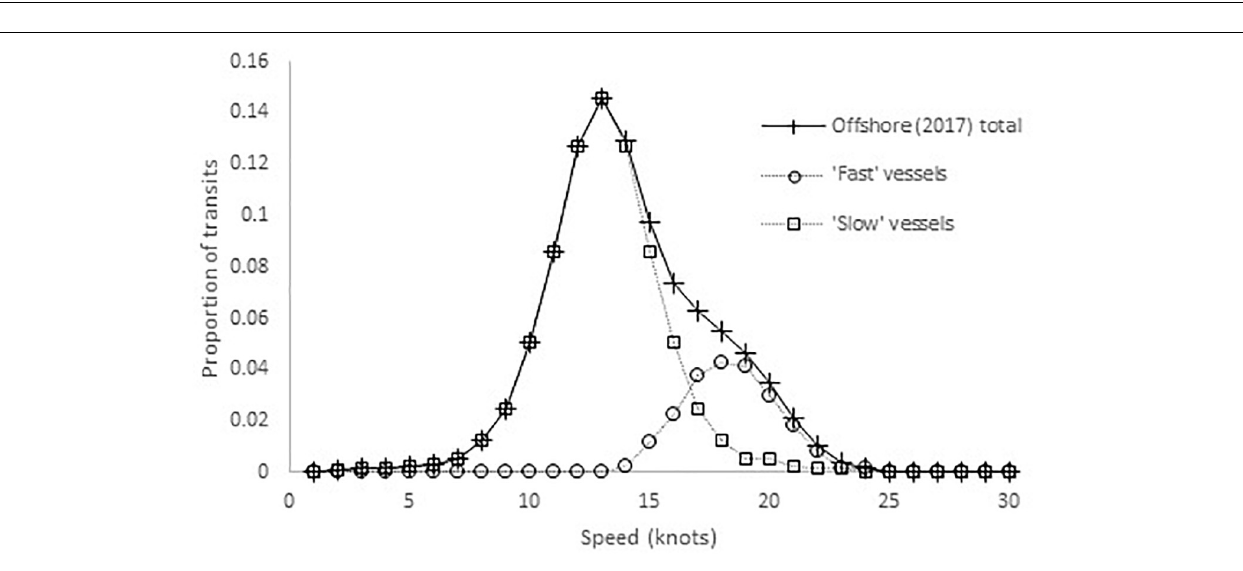
FIGURE 2 | Distribution of offshore vessel speeds in 2017 shown as the sum of two approximately symmetrical distributions representing “fast” and “slow”